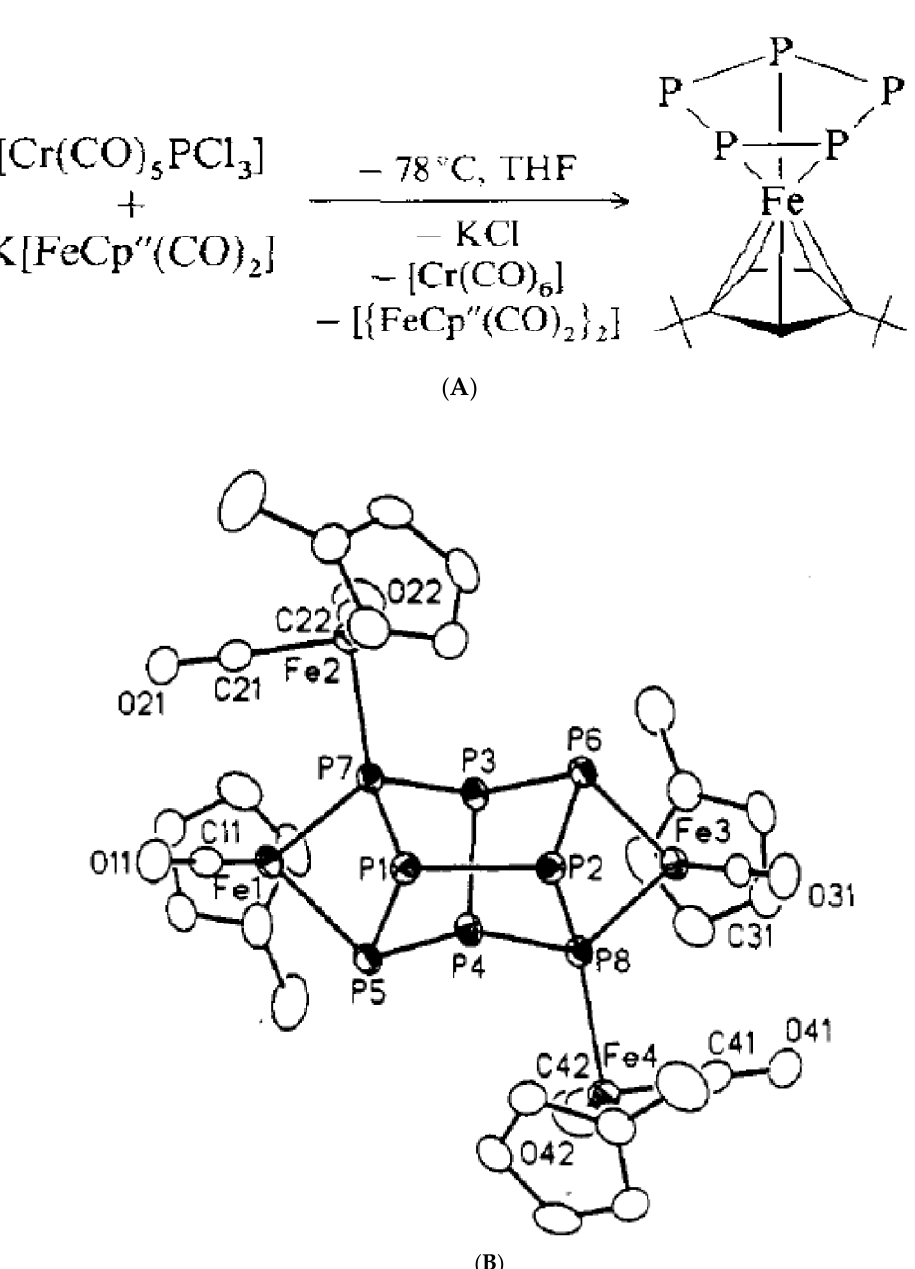
Figure 20. Formation of phosphorous oligomers by coordination on transition metals. ( A ) P 5 [89]; ( B ) P 8 [90].